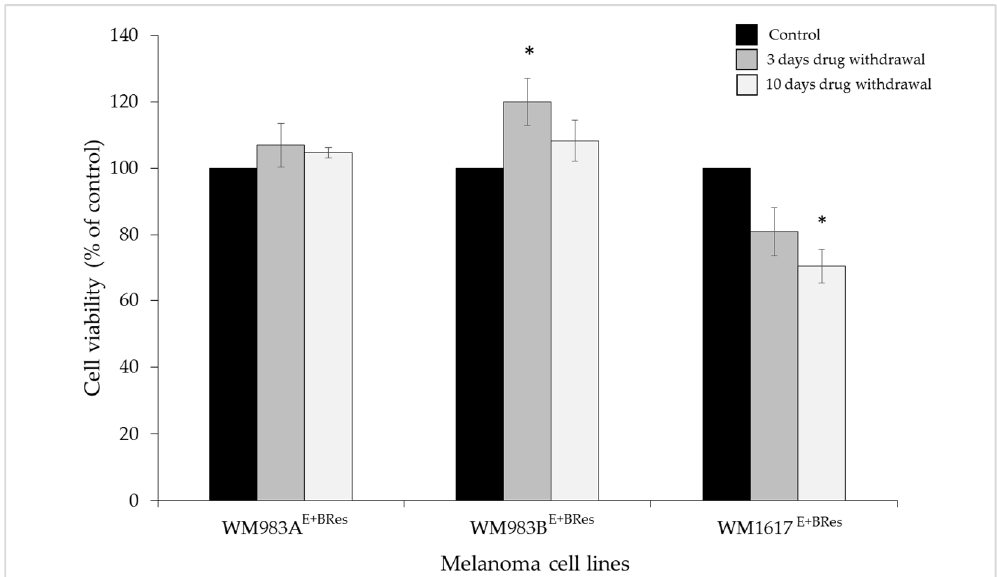
Figure 6. The effect of drug withdrawal on the viability of the resistant melanoma cell lines. Control cells were grown in the presence of 200 nM ENCO+BINI (black columns). Three days of drug withdrawal (cells grown in the presence DMSO for 3 days: dark grey columns), 10 days of drug withdrawal (cells grown in the presence DMSO for 10 days: light grey columns). The data are displayed as the mean ± SD of three independent experiments. The asterisk indicates a statistically significant difference (Mann–Whitney–Wilcoxon test; * p < 0.05).